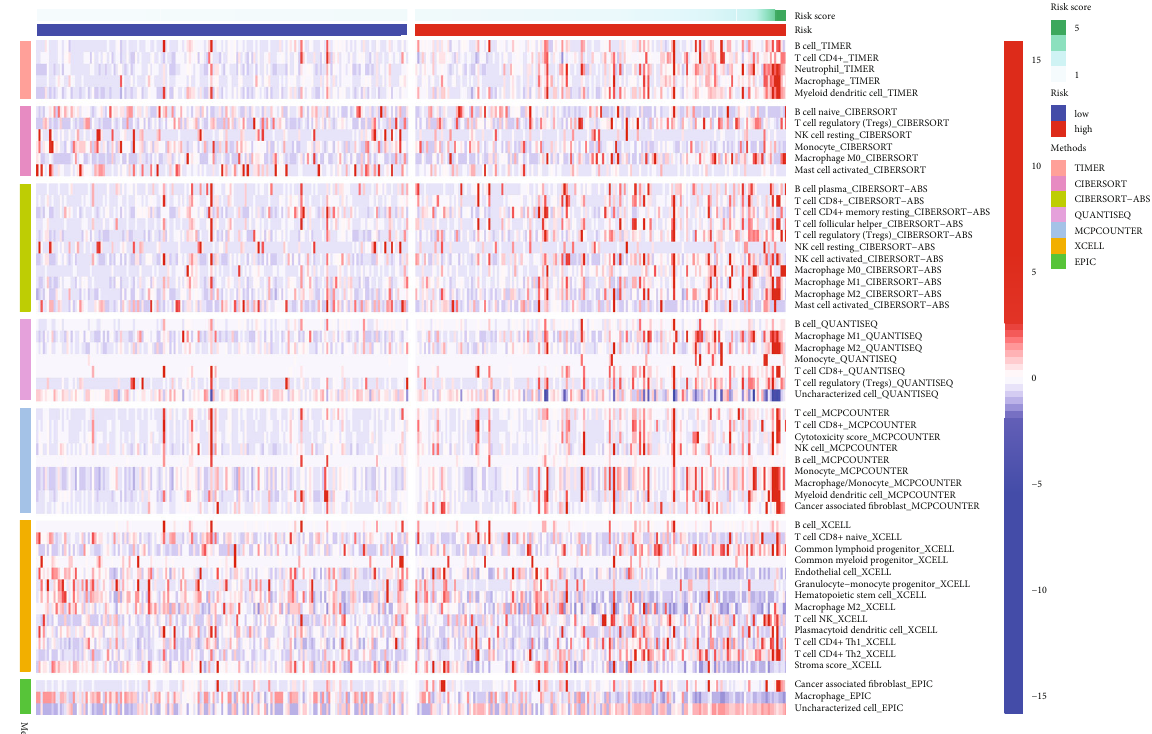
Figure 6: Heat map for immune responses according to fi ve algorithms among low- and high-risk